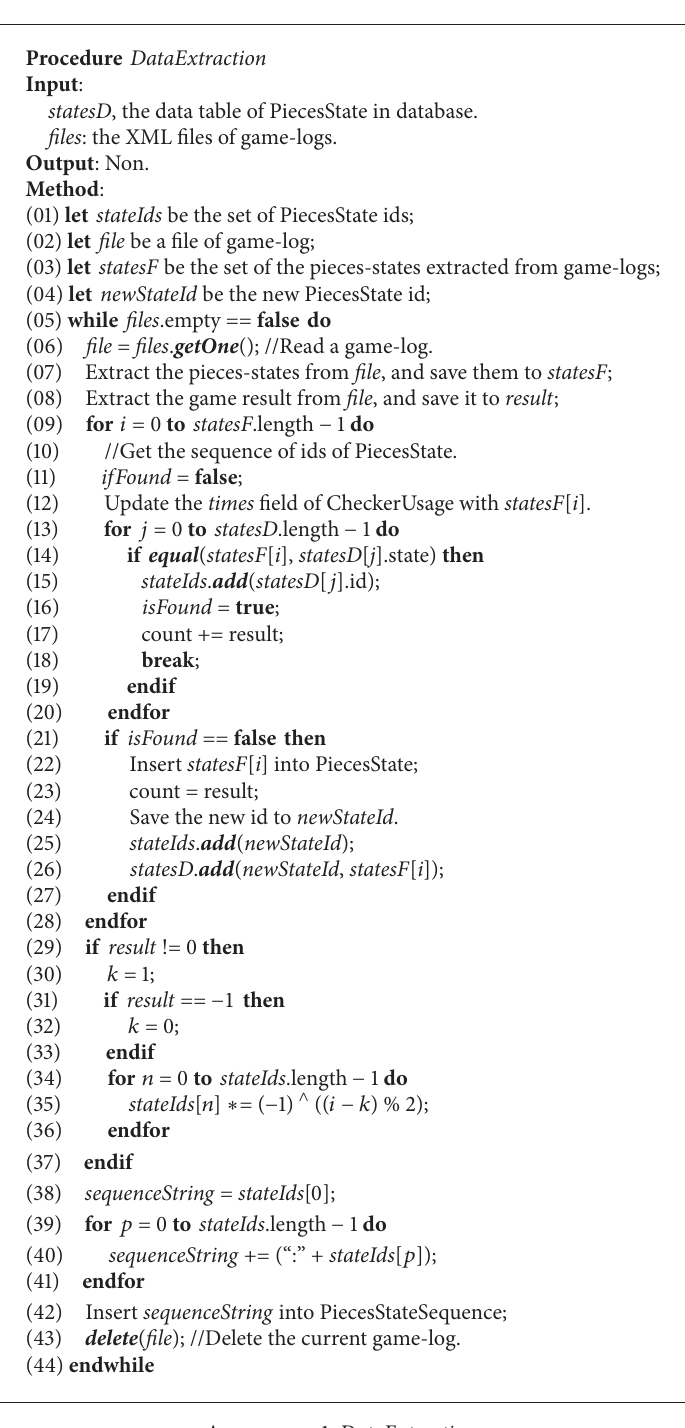
Procedure DataExtraction